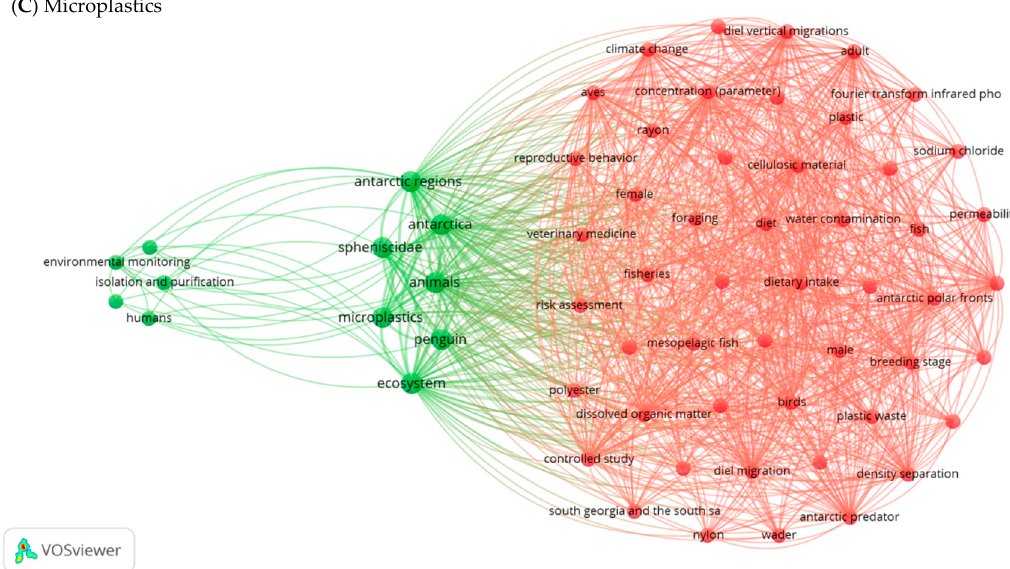
Figure 6. Visualization map of keyword analysis network on the impacts of pollutants towards penguins in Antarctica. ( A ) Heavy metals—clusters were distributed as follows: Cluster 1 (red) 16 items, Cluster 2 (green) 12 items, Cluster 3 (blue) 10 items, Cluster 4 (yellow) 10 items, Cluster 5 (purple) 7 items, Cluster 6 (light blue) 7 items, Cluster 7 (orange) 5 items, Cluster 8 (brown) 4 items and Cluster 9 (pink) 3 items. ( B ) Diesel—clusters represented as Cluster 1 (red) 48 items, Cluster 2 (blue) 19 items and Cluster 3 (green) 8 items. ( C ) Microplastics—clusters formed are displayed as Cluster 1 (red) 50 items and Cluster 2 (green) 12 items.